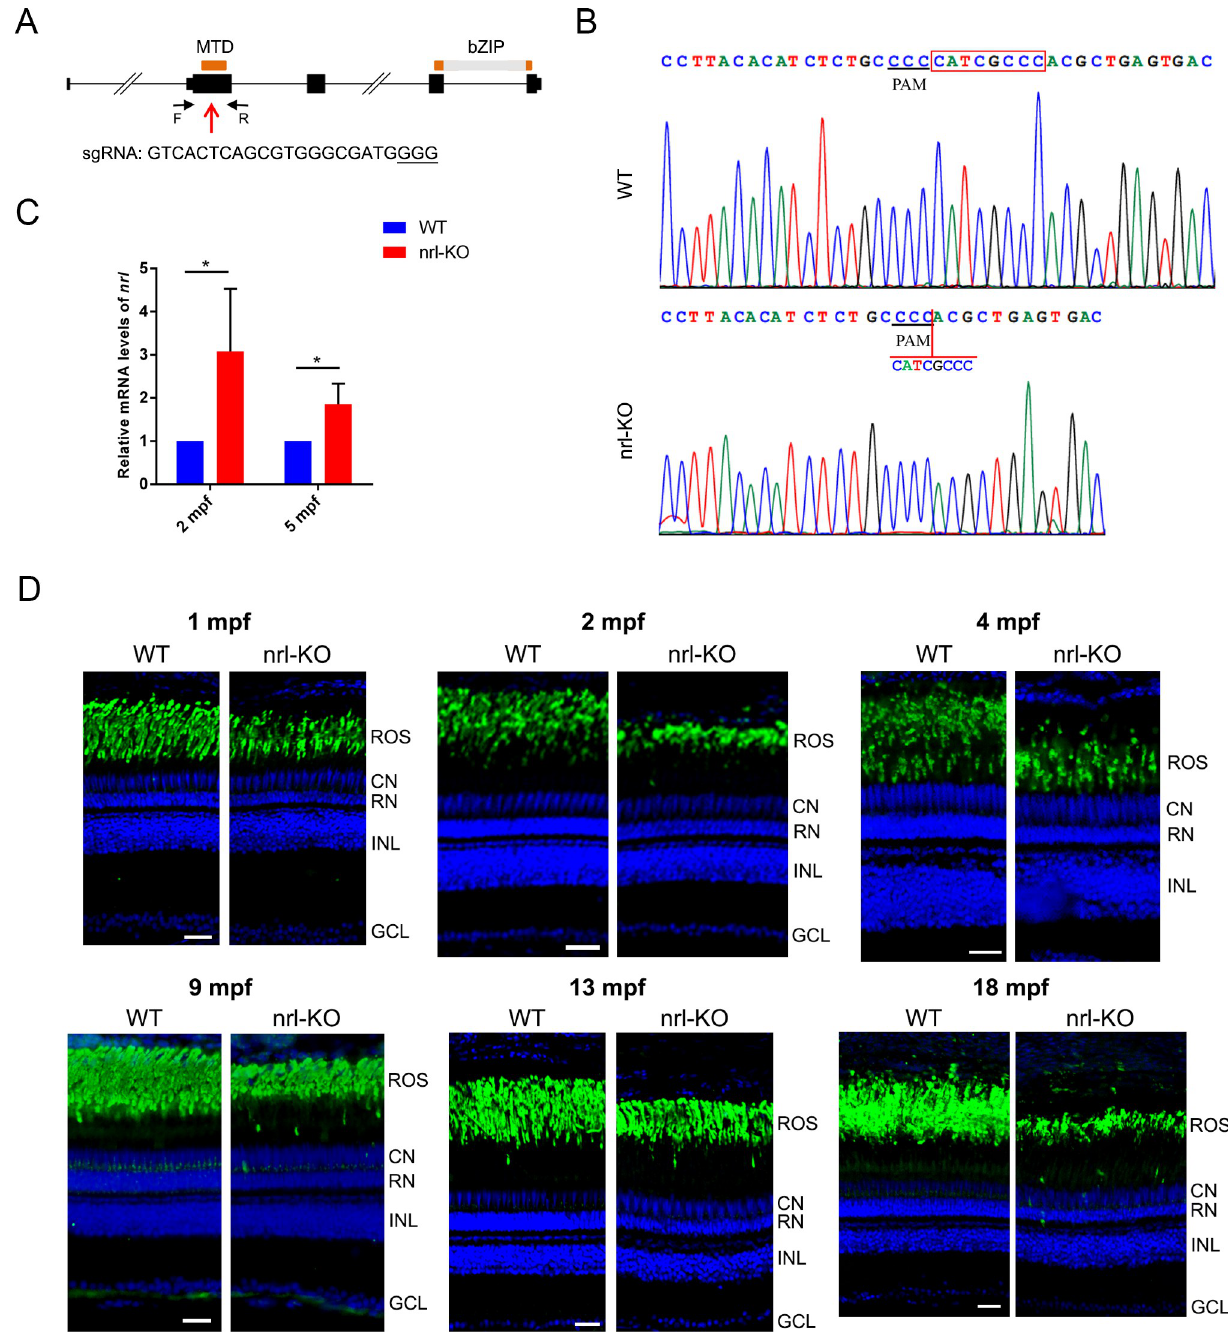
Fig 1. Knocking out nrl diminishes but does not eradicate the rod population in zebrafish. (A) The gene structure of zebrafish nrl and the CRISPR-Cas9 target site used for knocking out nrl are shown. Orange boxes, the exons encoding the MTD and bZIP domains; red arrow, the CRISPR-Cas9 target site; black arrows, the primers used for mutation detection. (B) Sequencing validation of the homozygous nrl del8 mutation (c.230_237del8). (C) The nrl mRNA levels in the nrl -KO zebrafish were measured using qPCR. The data are shown as mean with SD (n = 3). � , p < 0.05. (D) Immunostaining of retinal sections from WT and nrl -KO zebrafish from 1 mpf to 18 mpf with the anti-Rho antibody for the rod outer segments. Scale bars: 25 μ m. ROS, rod outer segment; CN, cone nuclear layer; RN, rod nuclear layer; INL, inner nuclear layer; GCL: ganglion cell